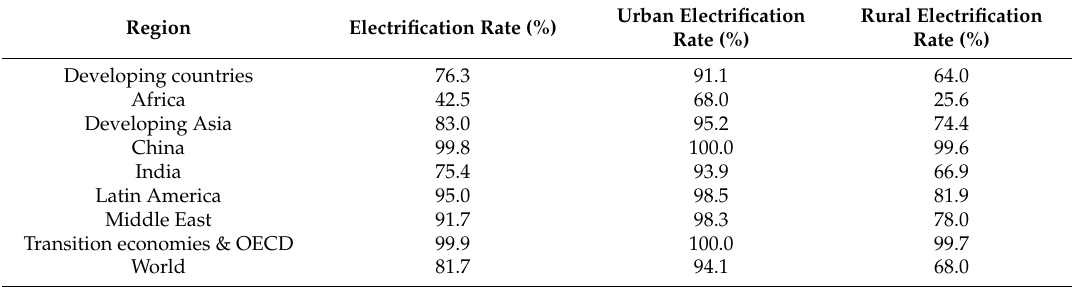
Table 1. Electricity access in 2012: regional aggregates. Data source: IEA, World Energy Outlook 2014